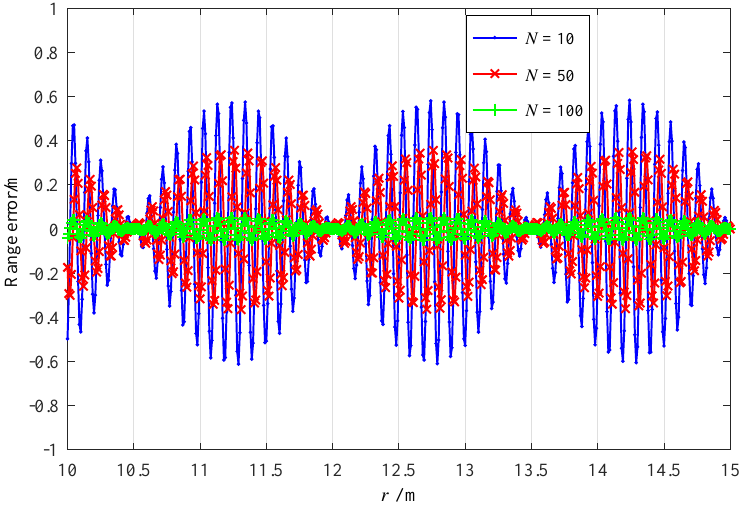
Figure 4. Range error versus r when N = 10, 50, 100; and v r = 10